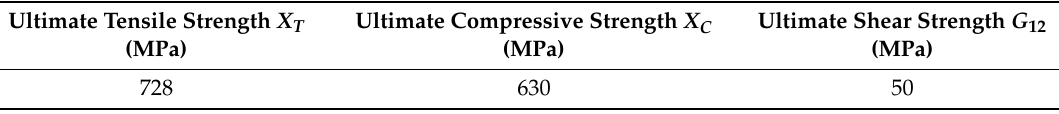
Table 2. Lamina strength properties used in the Abaqus model (Experimentally